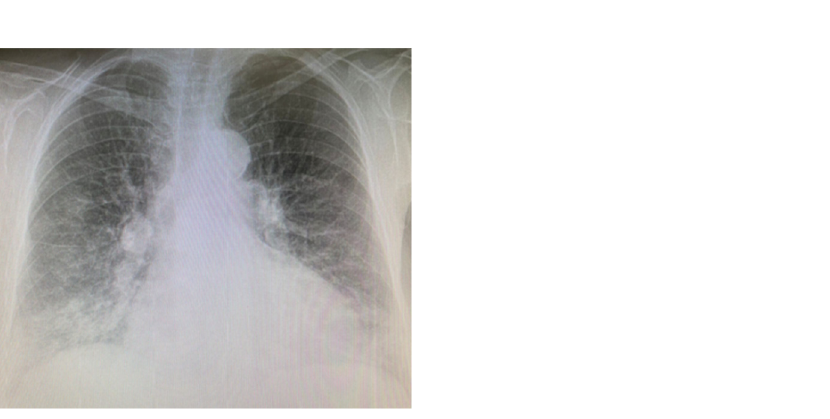
Figure 6. Chest X-Ray—2017—Case 3. Nodular and micronodular opacities localized mainly in the lower lobes. Veiling of the pulmonary bases. Reticular opacities on both pulmonary areas. Enlarged cardiac silhouette.